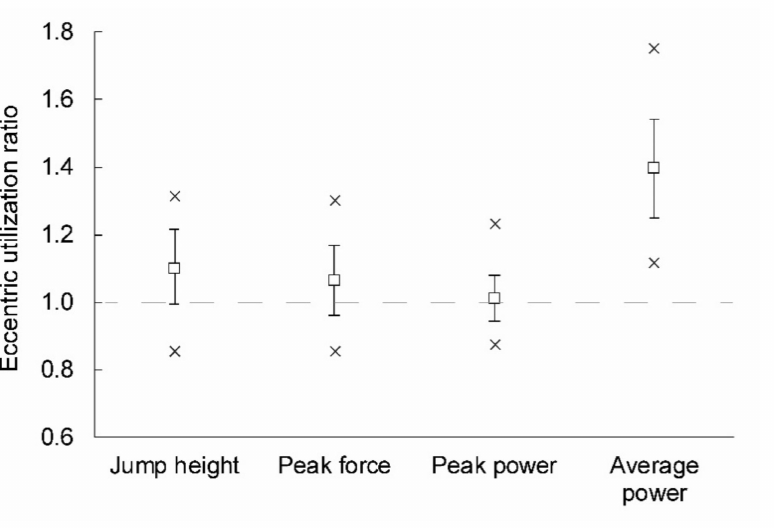
Figure 1. The eccentric utilization ratio across the outcome variables. Note that in addition to means and standard deviations, minimum and maximum values are depicted with a ×